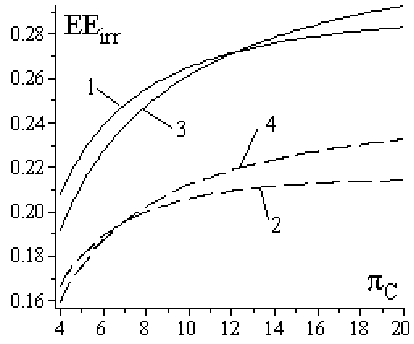
Figure 6. Dependences EE irr = f E ( π C ).